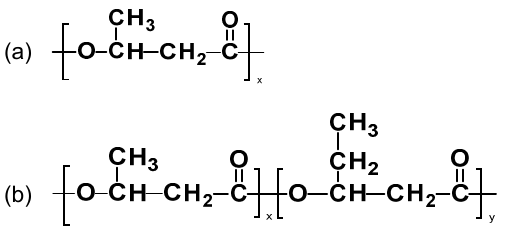
Figure 5. Chemical structures of ( a ) poly( β -hydroxybutyrate) (PHB) and ( b ) poly(3-hydroxybutyrate-co-3-hydroxyvalerate (PHBV).